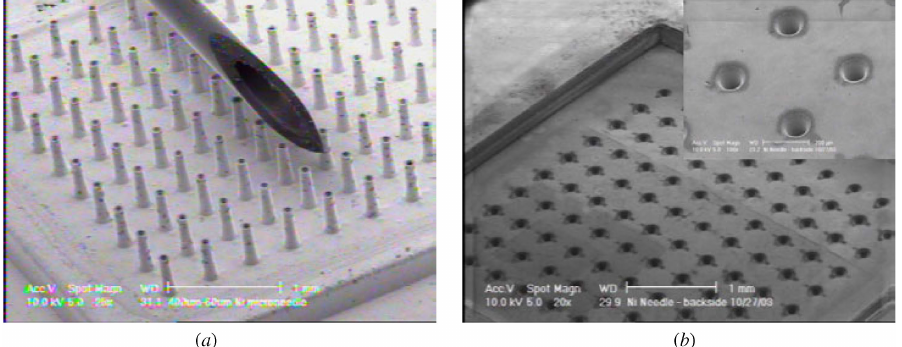
Figure 6. SEM images of a fabricated microneedle array: ( a ) 400 μm tall tapered hollow metallic microneedle array in comparison with a conventional gauge 28 stainless steel needle; ( b ) back-side of the microneedle array showing a fluidic reservoir and fluidic channels (through holes). Reprinted with permission from [27], copyright 2004 Institute of Physics.